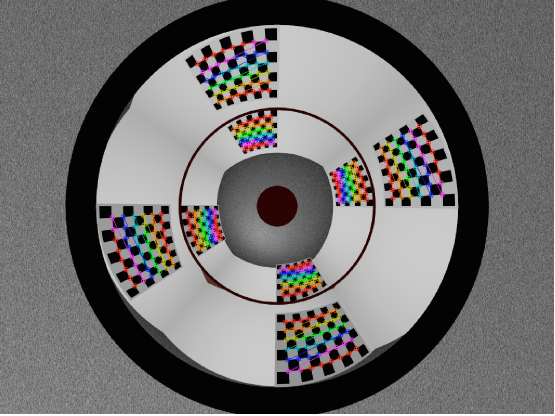
Figure 23. Example of sparse point correspondences detected with subpixel precision from corners on the chessboard patterns around the omnistereo sensor. The size of the rendered images for this experiment is 1280 × 960 pixels. For this example’s patterns, the square cell size is 140mm. The RMSE for this set of points at [ C ] ρ G = 2m is approximately 15mm (Table